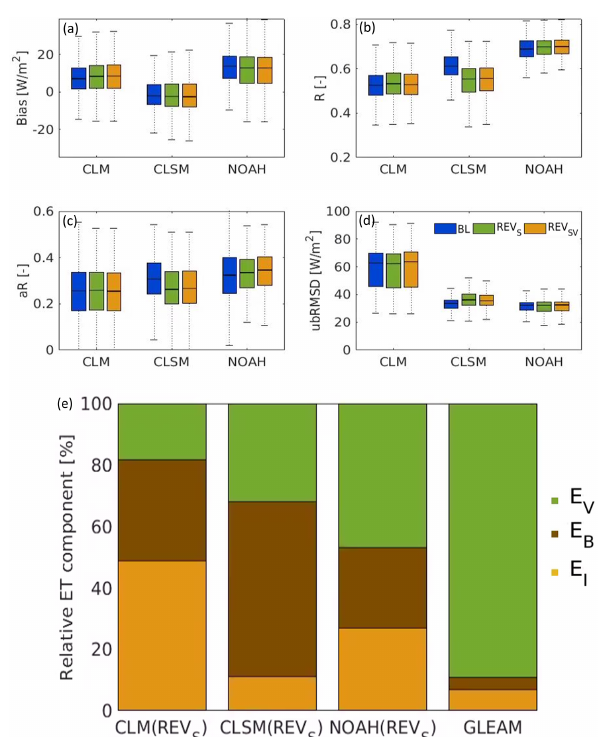
Figure 11. (a–d) Skill metrics for total ET from CLM, CLSM, and NOAH (BL, REV SV and REV SV ) relative to GLEAM, calculated for the period 1992–2015 over all pixels inside the Dry